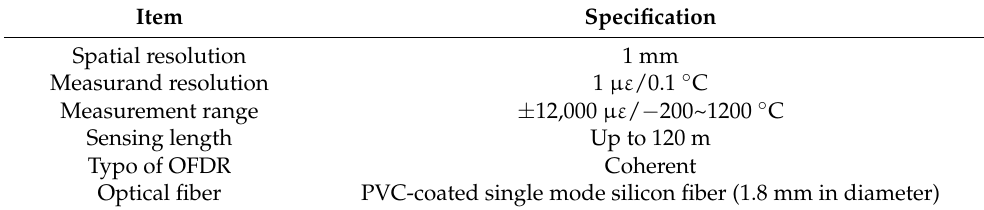
Table 2. Specification of OFDR interrogator and optical fibers.